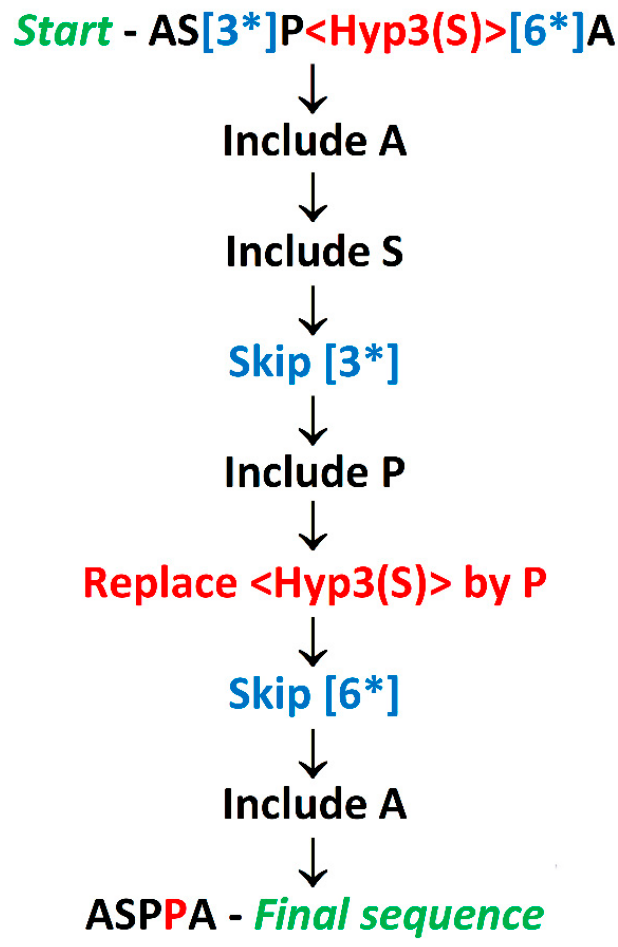
Figure 2. Steps of peptide AS[3*]<Hyp3(S)>[6*]A conversion into an unmodified sequence using